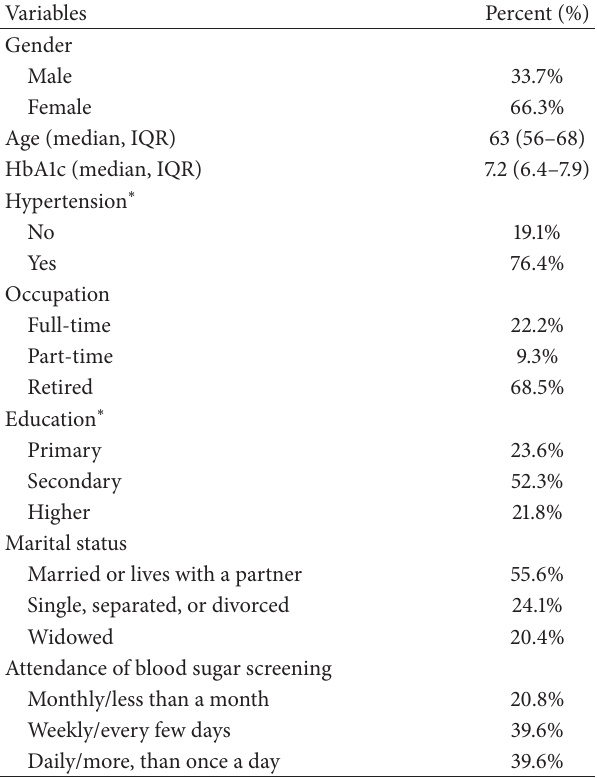
Table 1: Patients’